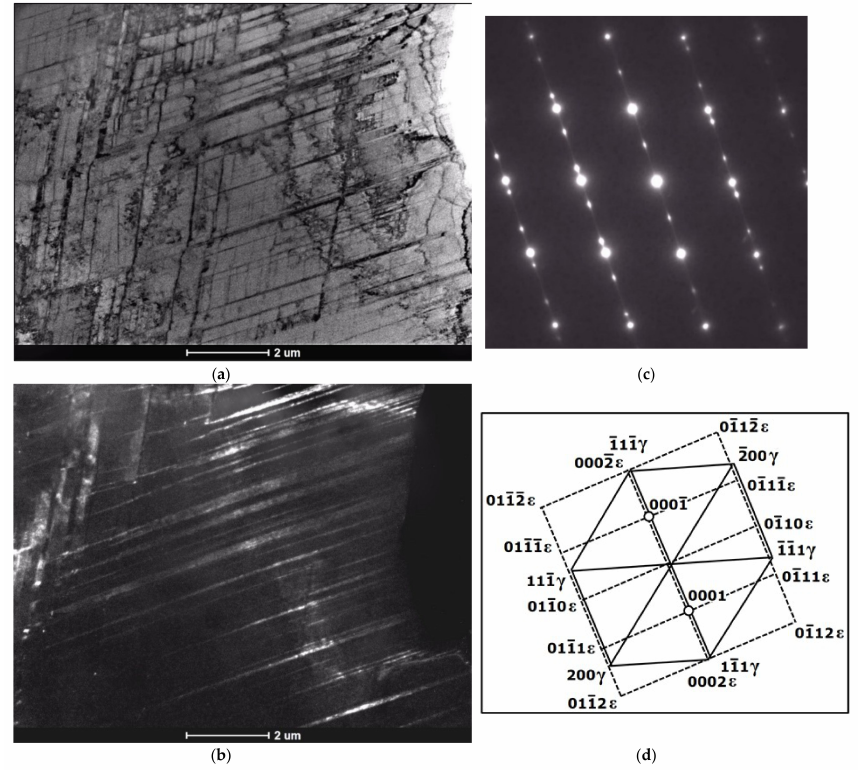
Figure 12. Bands of ε -martensite on the background of austenite matrix after 30% deformation; bright and dark field images ( a , b ) and SAED pattern with schematic representation ( c , d